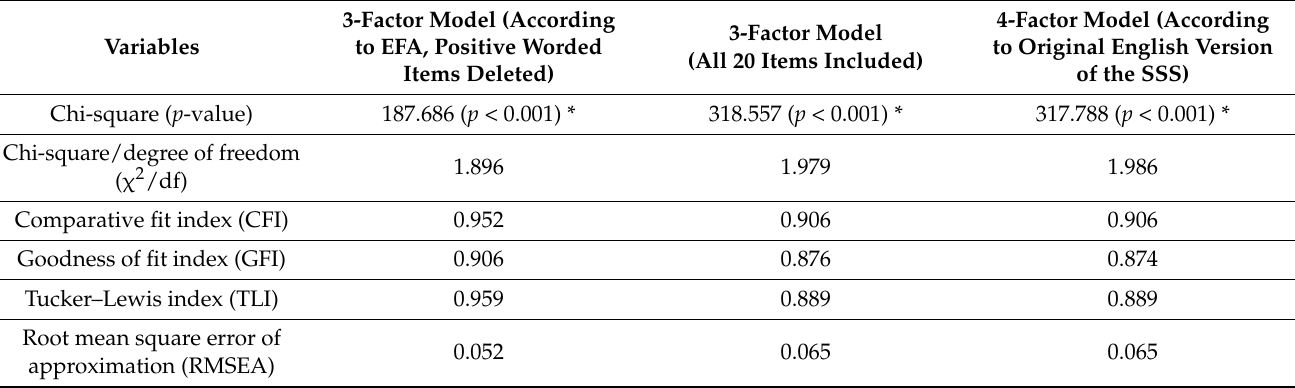
Table 5. The confirmatory factor analysis of three different models of the Malay version of the Shame and Stigma Scale